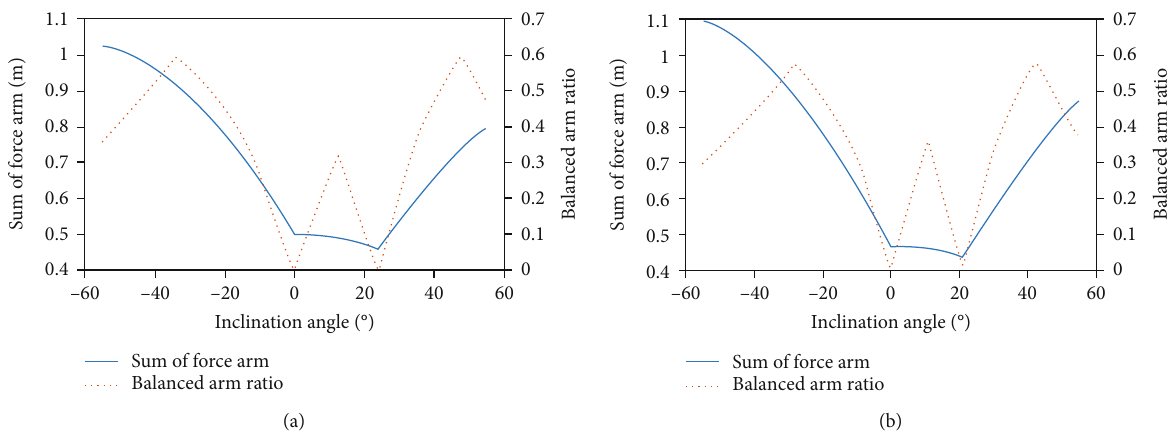
Figure 12: (a) The balanced force arm ratio alongside the ± X direction, and the sum of the initial force arm. (b) The balanced force arm ratio alongside the ± X direction, and the sum of the fi nal force